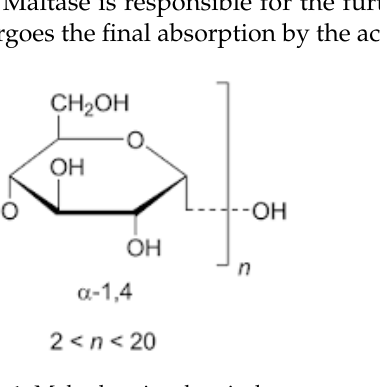
Figure 1. Maltodextrin: chemical structure and the main characteristics (n = glucose units per chain). Table 3. Main characteristics of maltodextrin.